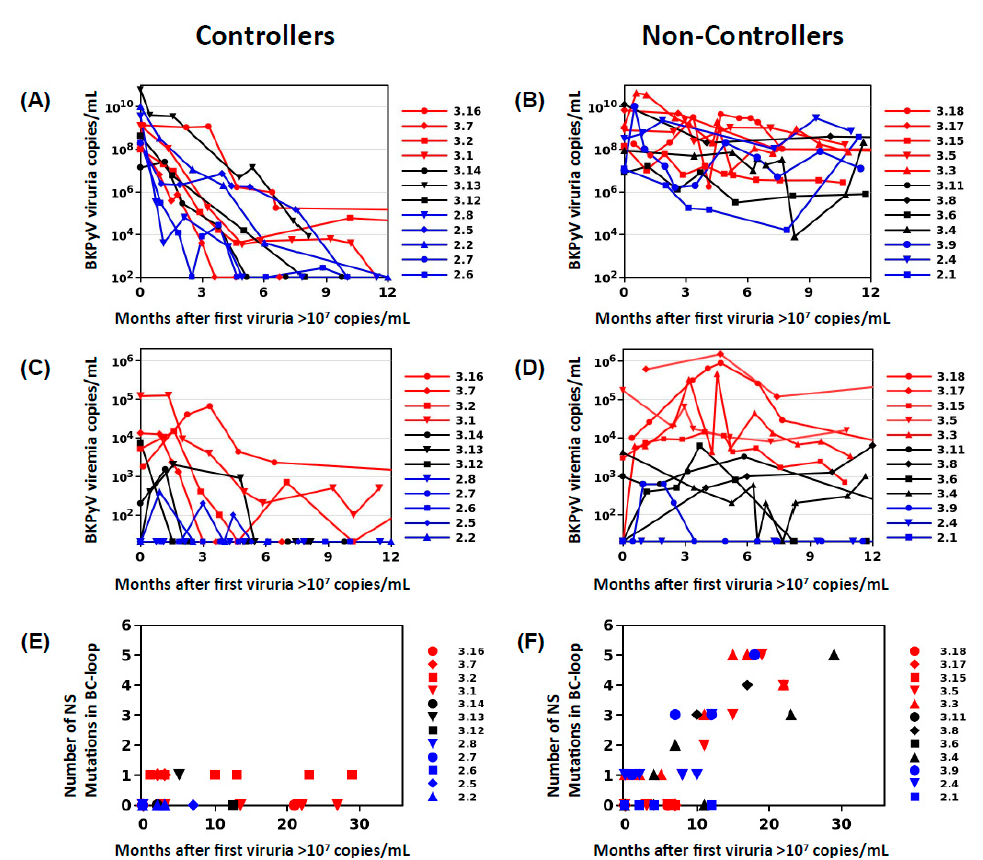
Figure 1. Evolution of viruria and VP1 mutations in controller and non-controller groups. Urine ( A , B ) and blood ( C , D ) viral load over time in controller ( A , C ) and non-controller ( B , D ) patients. Symbol colours correspond to high ( > 4log10 copies / mL, red), intermediate (between 3log10 and 4log10 copies / mL, black), and low ( < 3log10 copies / mL, blue) peak viremia. Accumulation of non-synonymous VP1 BC-loop mutations in non-controller ( F ), but not in controller patients ( E ). For each sample analyzed by PCR and Sanger sequencing, the number of di ff erences compared to wild-type was plotted against time after first viruria > 10 7 copies / mL. Blue symbols in panel E show patients who accumulate BC-loop mutations in the absence of viremia.